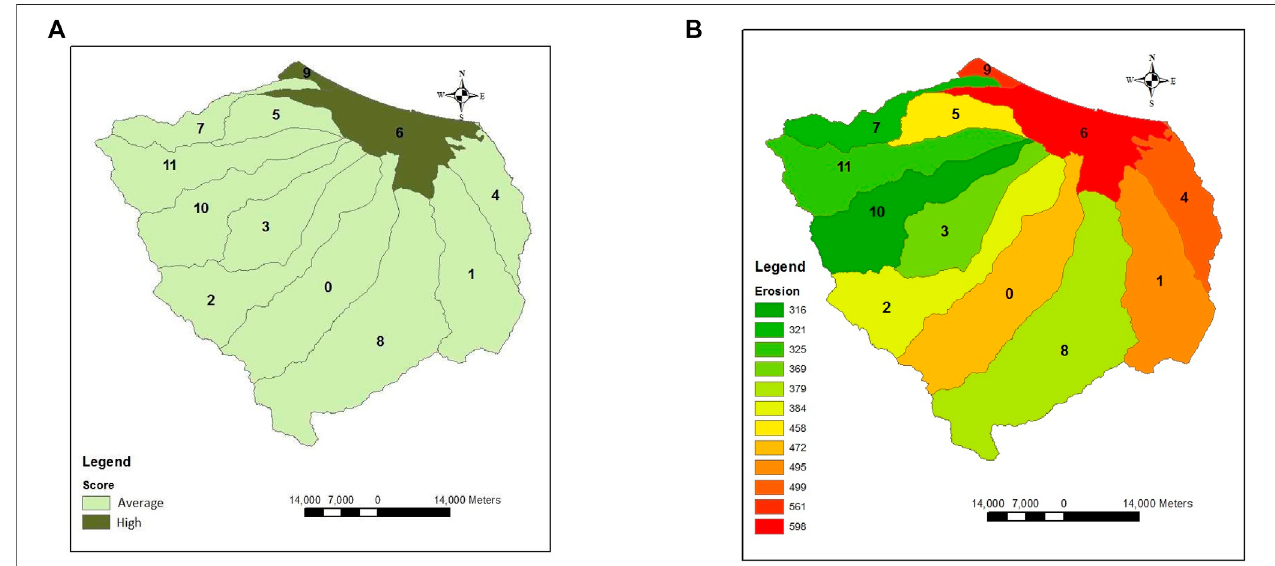
FIGURE 3 | Spatial distribution of erosion intensity resulted from the MPSIAC model: (A) qualitive erosion, (B) sedimentation yields of the Anzali watershed.